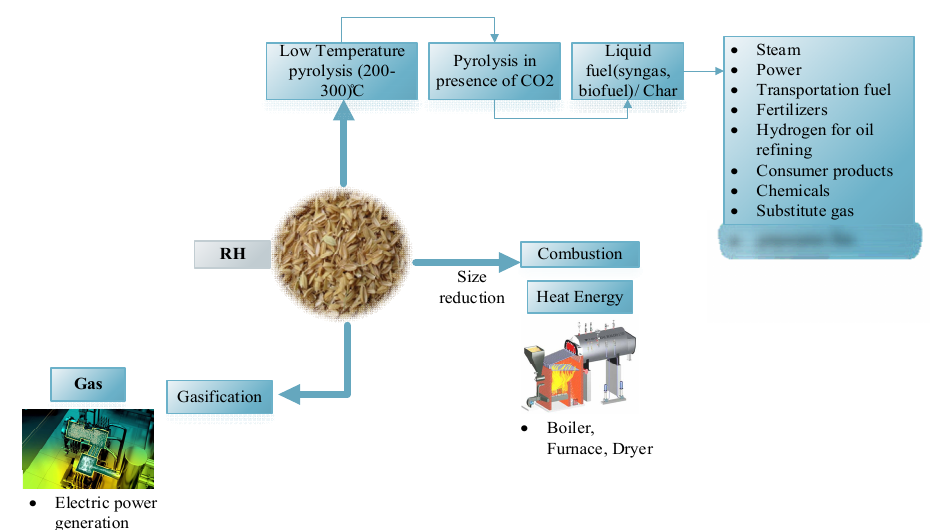
Figure 7. Possible energy applications of RH-derived AC and RH.